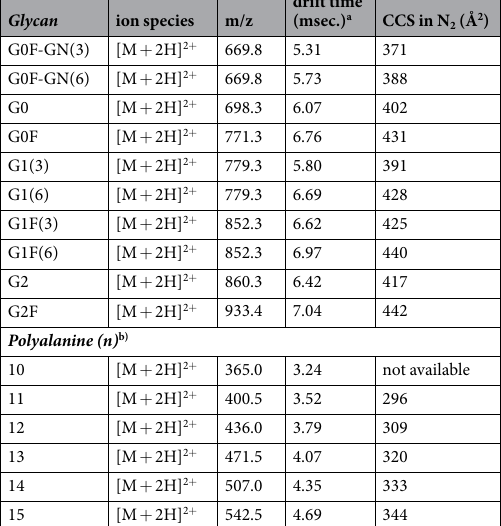
Table 1. Experimentally measured drift times and estimated collision cross sections (CCSs) in N 2 gas for ten doubly protonated PA-glycans. CCS values of doubly protonated polyalanines used for the calibration are also shown for comparison. a Ref. 23 . b Ref. 36 . A good linearity was found for the drift time ( t ) and CCS of polyalanine (CCS = 41.3 × t + 152 with R 2 = 0.996).